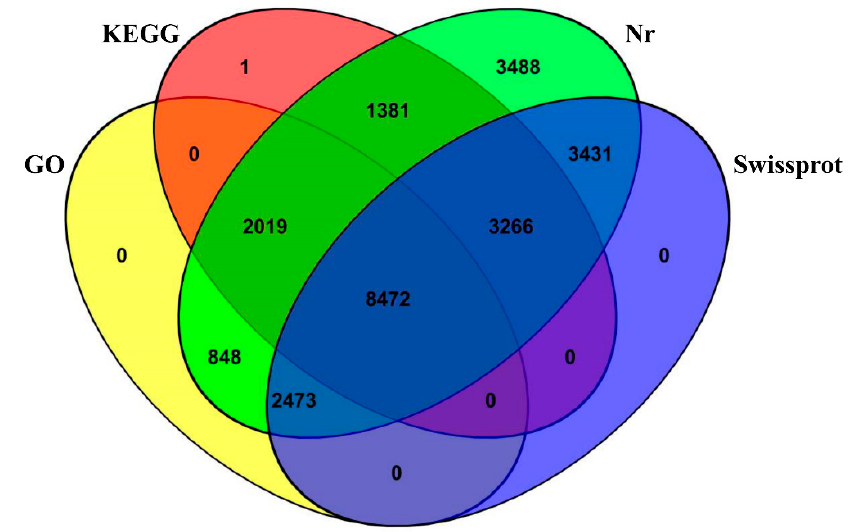
Figure 3. Venn diagram showing the annotation by four databases. For homology annotation, non-redundant sequences were searched using public databases, including the Nr, Swiss-Prot, KEGG, and GO databases.